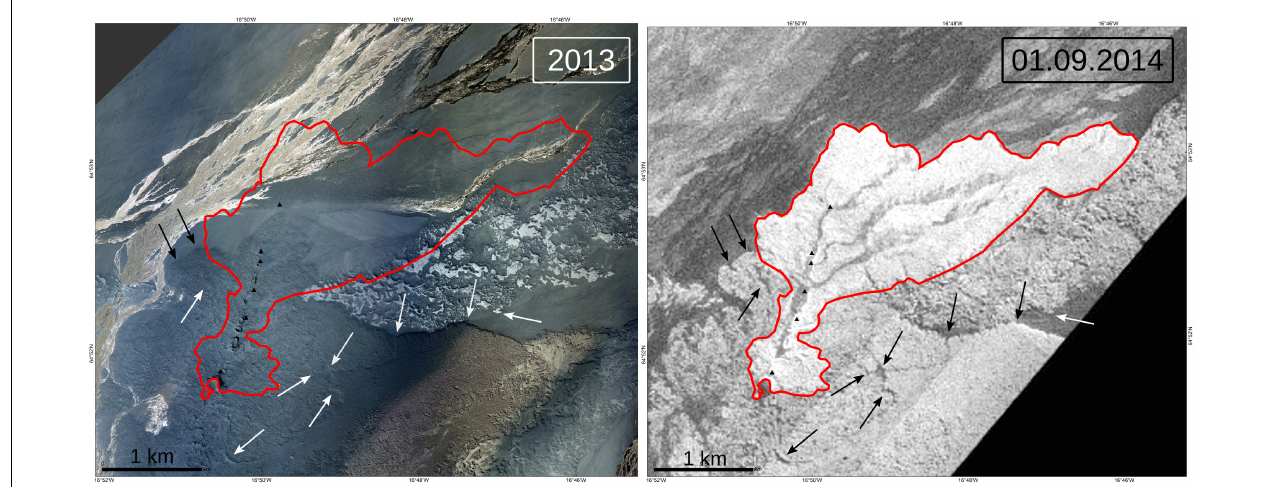
FIGURE 7 | Example of image georeferencing for mapping the lava field. (Left) The high resolution optical aerial image acquired in 2013 by Loftmyndir Inc., show the floodplain and the eroded Holuhraun I lava, formed in 1797 CE (Hartley and Thordarson, 2013), where the 2014–2015 eruption took place. (Right) SAR aerial amplitude image acquired by the Icelandic Coast Guards on September 1, 2014. The red line shows the lava outline on September 1, 2014, the black triangles show the cones formed during 2014–2015 Holuhraun eruption. The arrows point toward common features in both images that helped for georeferencing the SAR amplitude